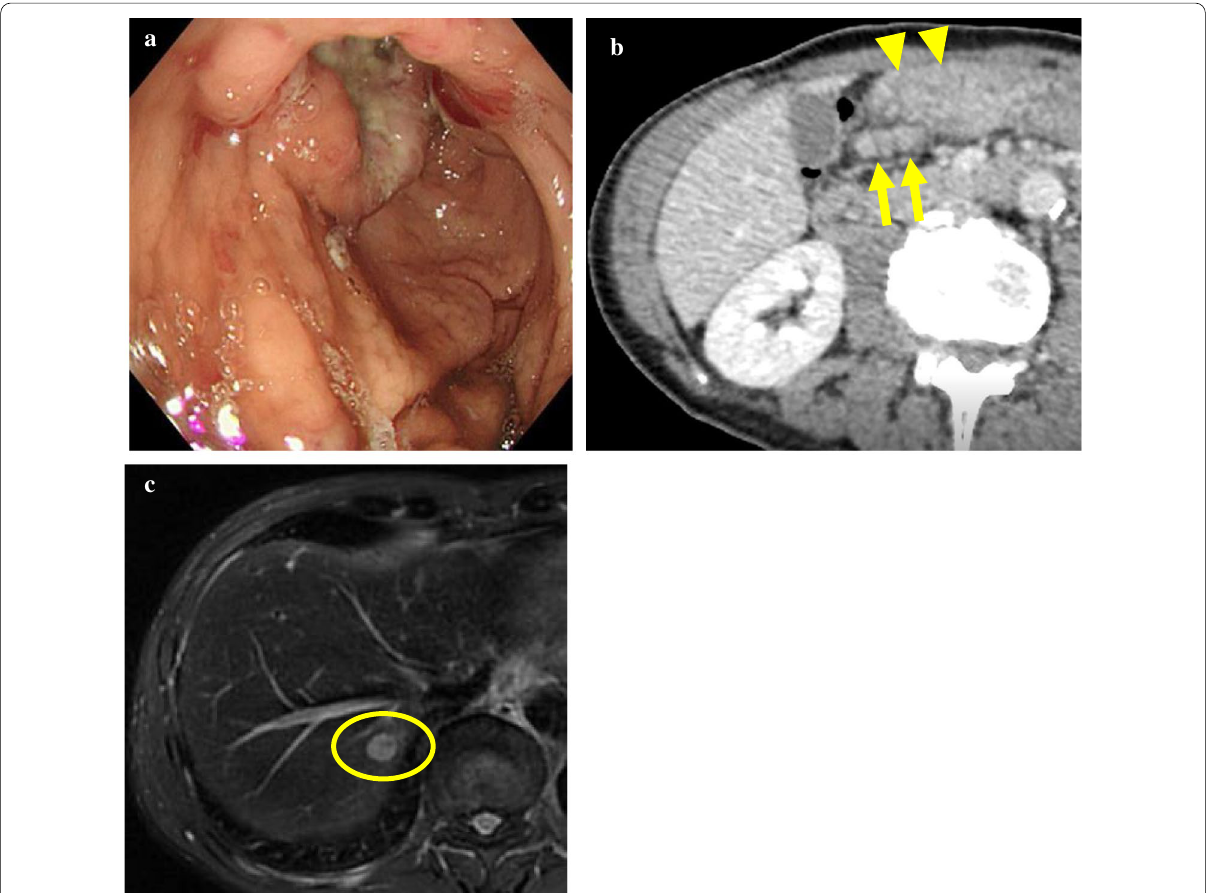
Fig. 1 Image findings at the initial hospital visit (before any treatment). a Upper gastrointestinal endoscopy showed a type 2 circumferential tumor with a gastric outlet obstruction located at the gastric antrum. b Abdominal contrast-enhanced CT revealed a thickened gastric wall at the pre-pyloric area (triangle) and two swollen regional lymph nodes at station No. 6 (arrow). c On MRI, a highly enhanced lesion measuring 10 mm in diameter was detected in the liver S7